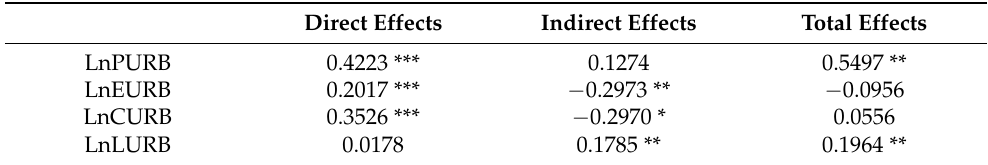
Table 18. Direct Effects, Indirect Effects and Total